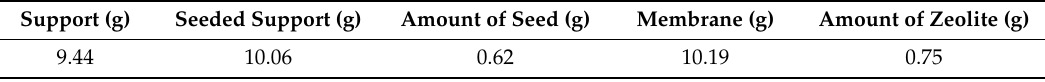
Table 3. Amount of the support, seeded support, and final membrane